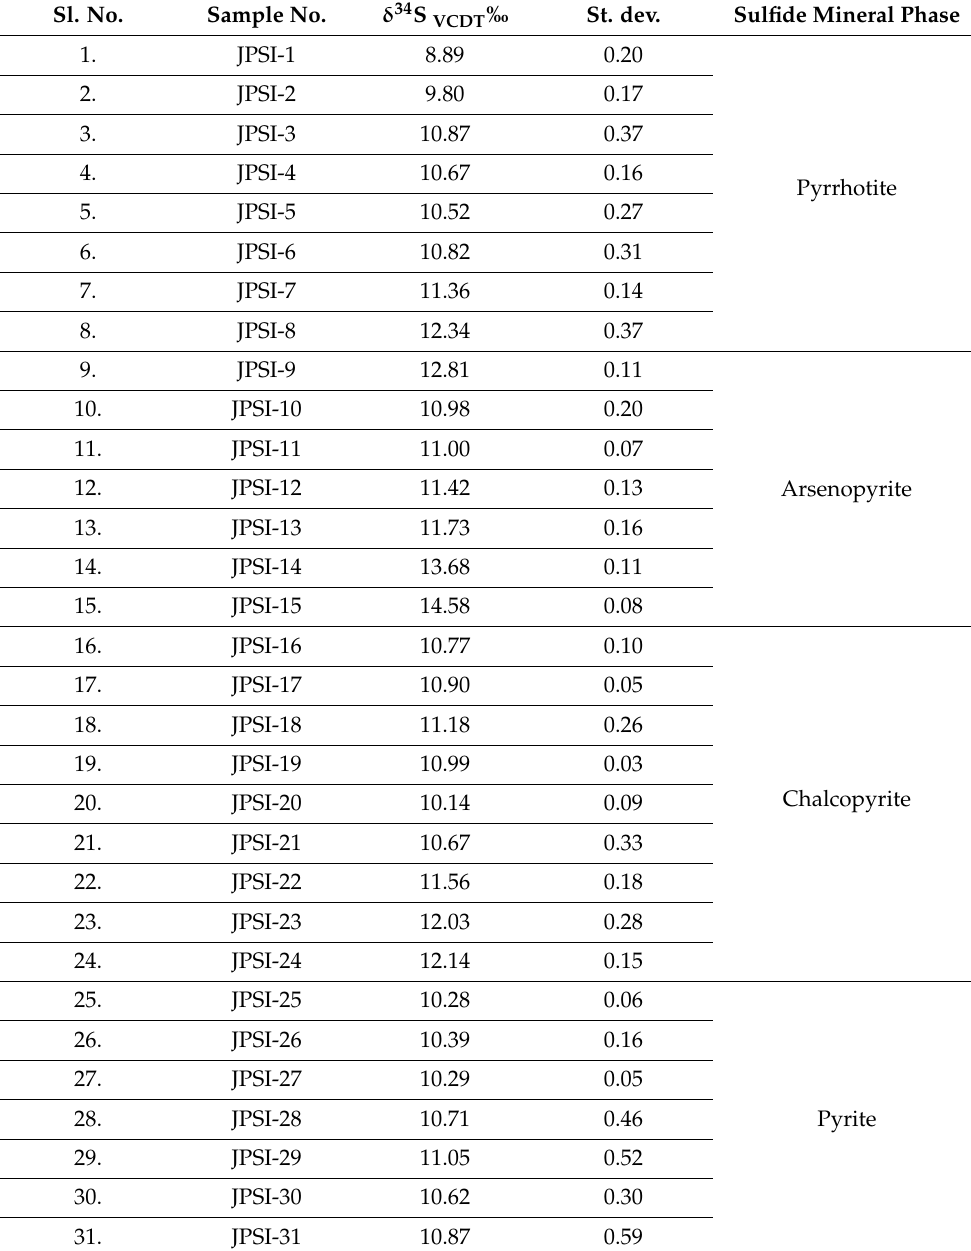
Table 5. δ 34 S VCDT (‰) values of various sulfide minerals of the Jagpura deposit. Sl. No. Sample No. δ 34 S VCDT ‰ St. dev. Sulfide Mineral